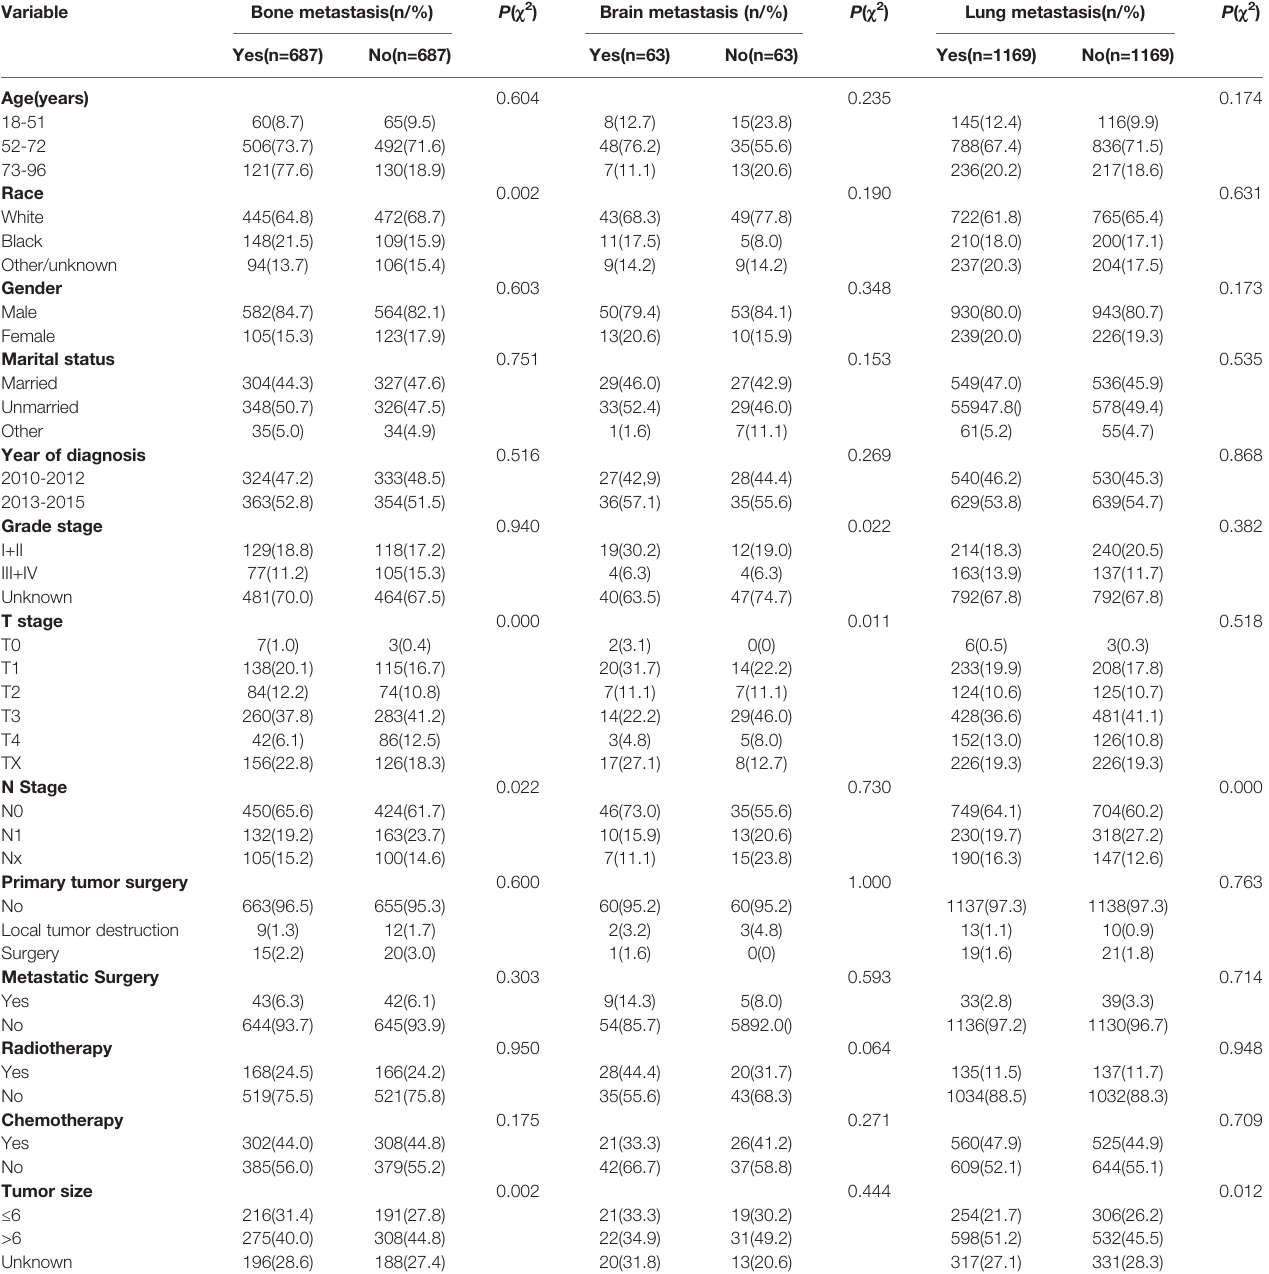
TABLE 3 | The relationship between different metastatic sites and clinical features (after PSM). Variable Bone